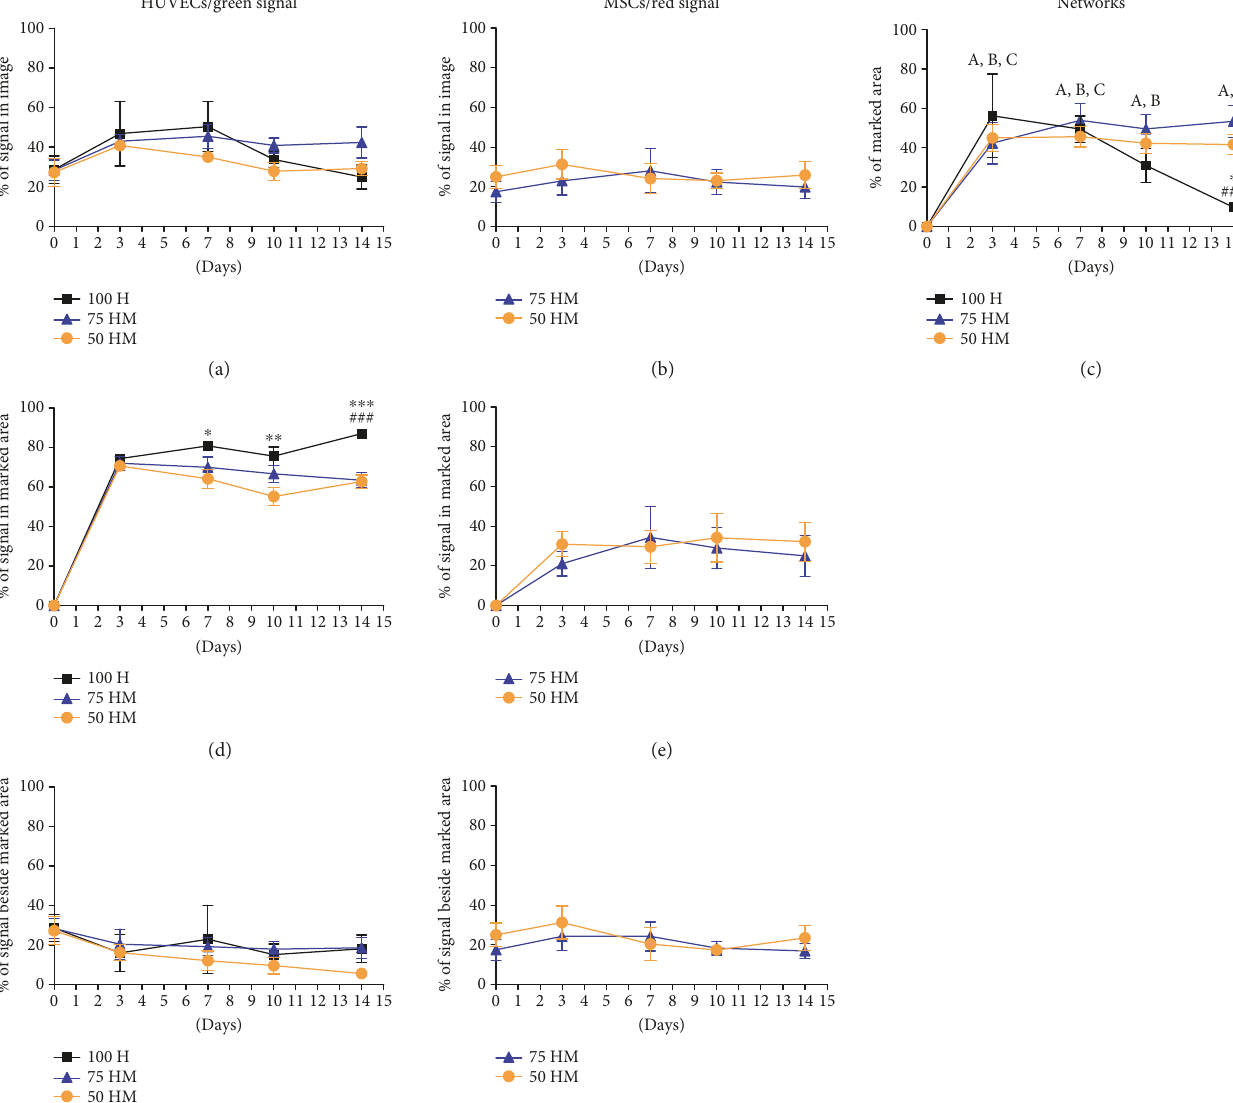
42 ± 7.9%, and 29 ± 3.5% at day 14 for 100 H, 75HM, and 50 HM cultures, respectively. A similar pattern was observed for the red fl uorescence signal, that is, the MSCs (Figure 5(b)). These fi ndings demonstrate that over the course of the experiment, cells were apparent at least in a